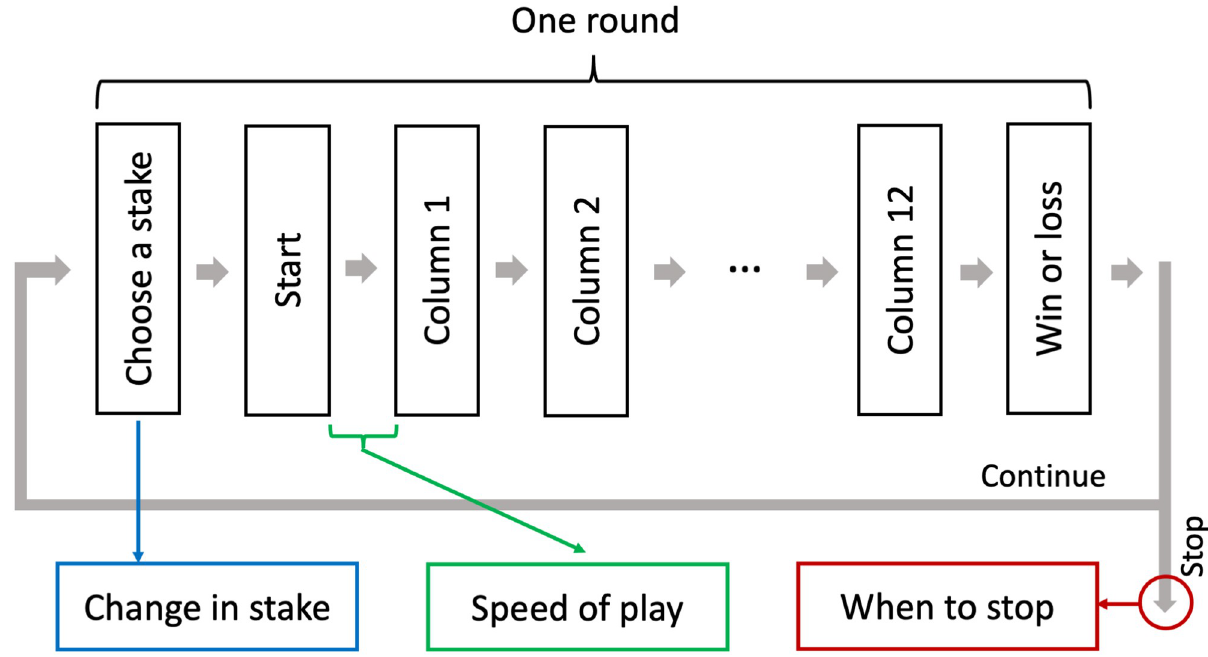
Fig 1. A flowchart showing the events within one round, and on which event each expression of loss-chasing is based.